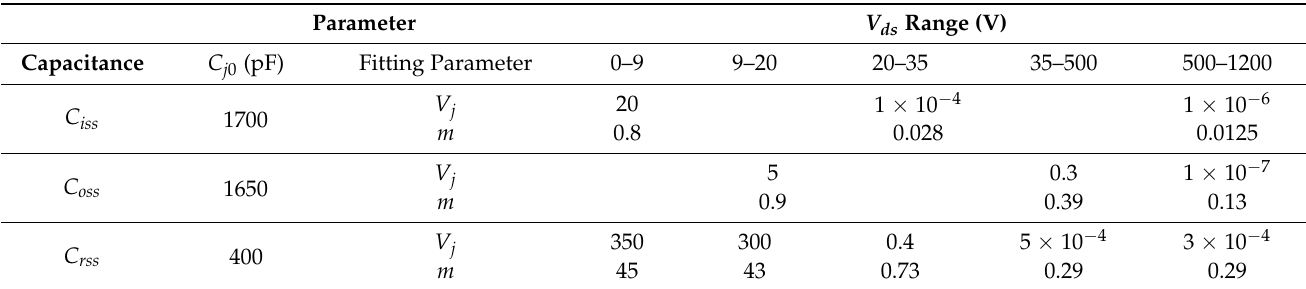
Table 3. Parameters of Capacitance Piecewise Fitting Model.